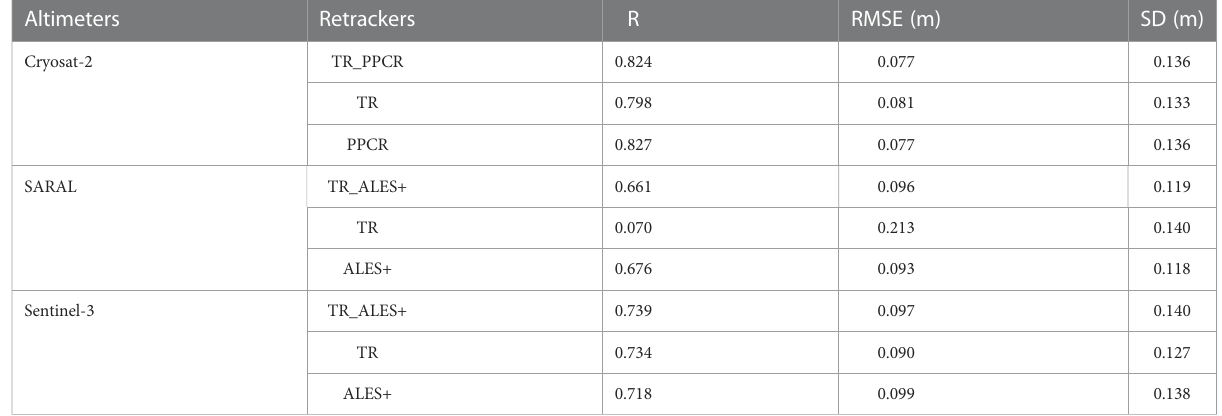
TABLE 6 Comparison of estimation accuracy of coastal water level between single and multiple